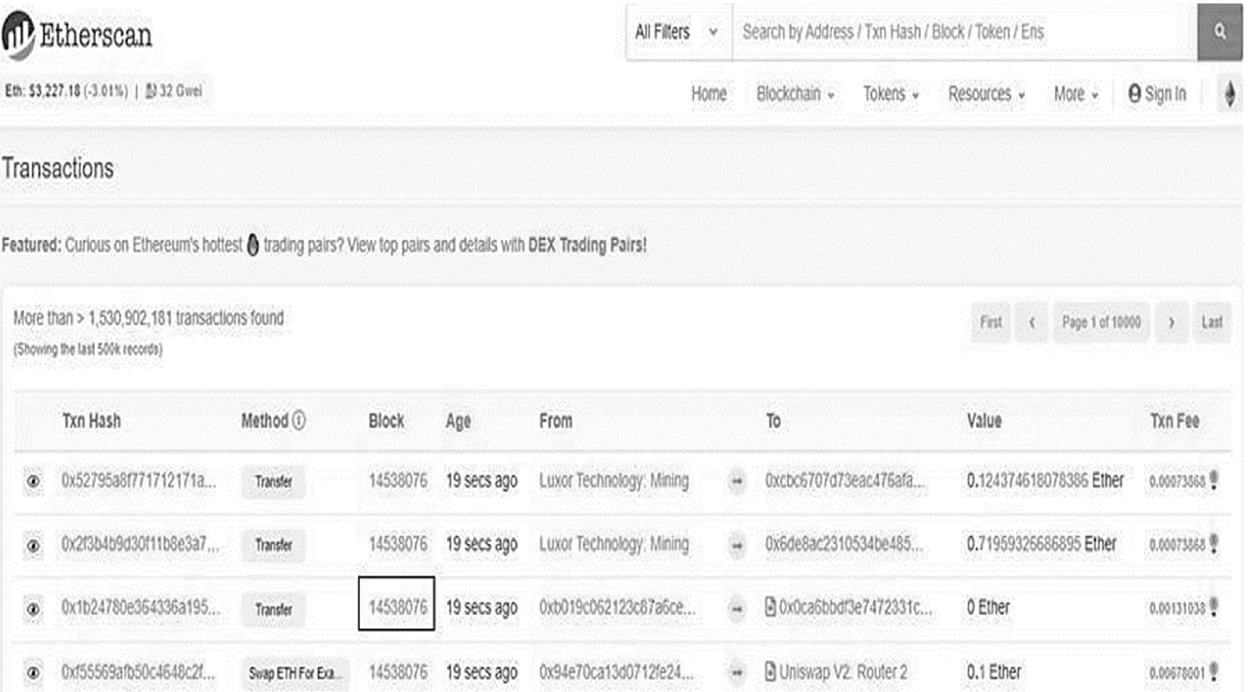
Figure 9. Etherscan proof of data maintained over a blockchain.